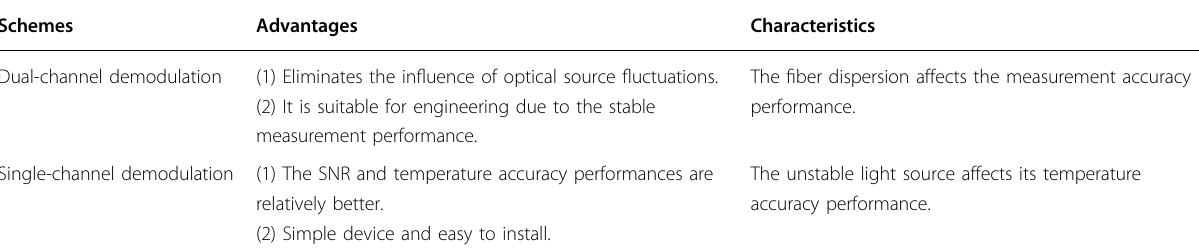
Table 1 Comparison of the dual-channel demodulation and single-channel demodulation principles Schemes Advantages Characteristics Dual-channel